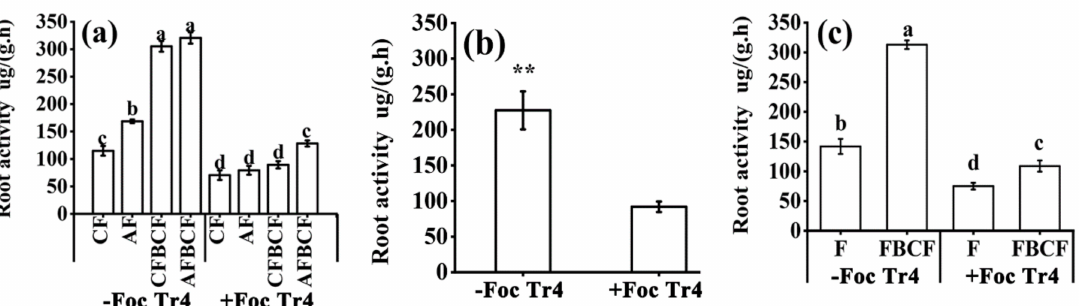
Figure 4. Effects of alkaline fertilizer and biocontrol fungi on banana root activity. ( a ) Effect of each treatment on root activity. ( b ) Effect of inoculation of pathogen (main plots) on banana root activity. ( c ) Effect of biocontrol fungi (sub-plots) on banana root activity. Different small case letters on the bars indicate significant difference ( p < 0.05) among the treatments. ** indicated that there was extremely significant difference between inoculation and without inoculation of the Foc Tr4 ( p ≤ 0.01). CF stands for conventional fertilizer. AF stands for alkaline fertilizer. CFBCF stands for conventional fertilizer and biocontrol fungi. AFBCF stands for alkaline fertilizer and biocontrol